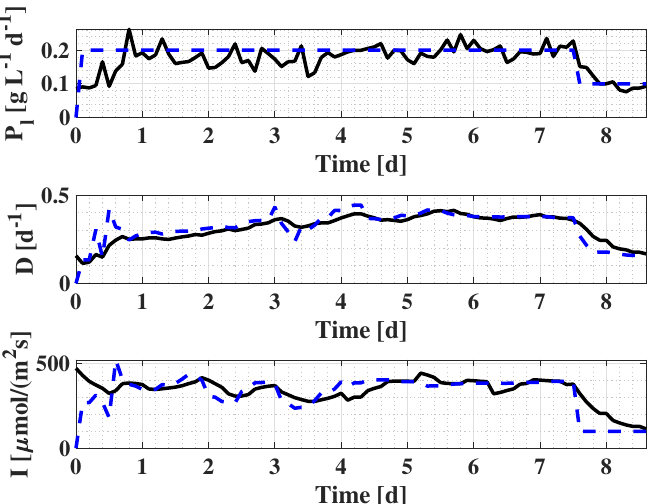
Figure 9. Time evolution of productivity, dilution rate and light intensity during the experimental validation of the SSC method. Dashed lines, calculated references; continuous lines, measured productivity and SSC computed inputs.